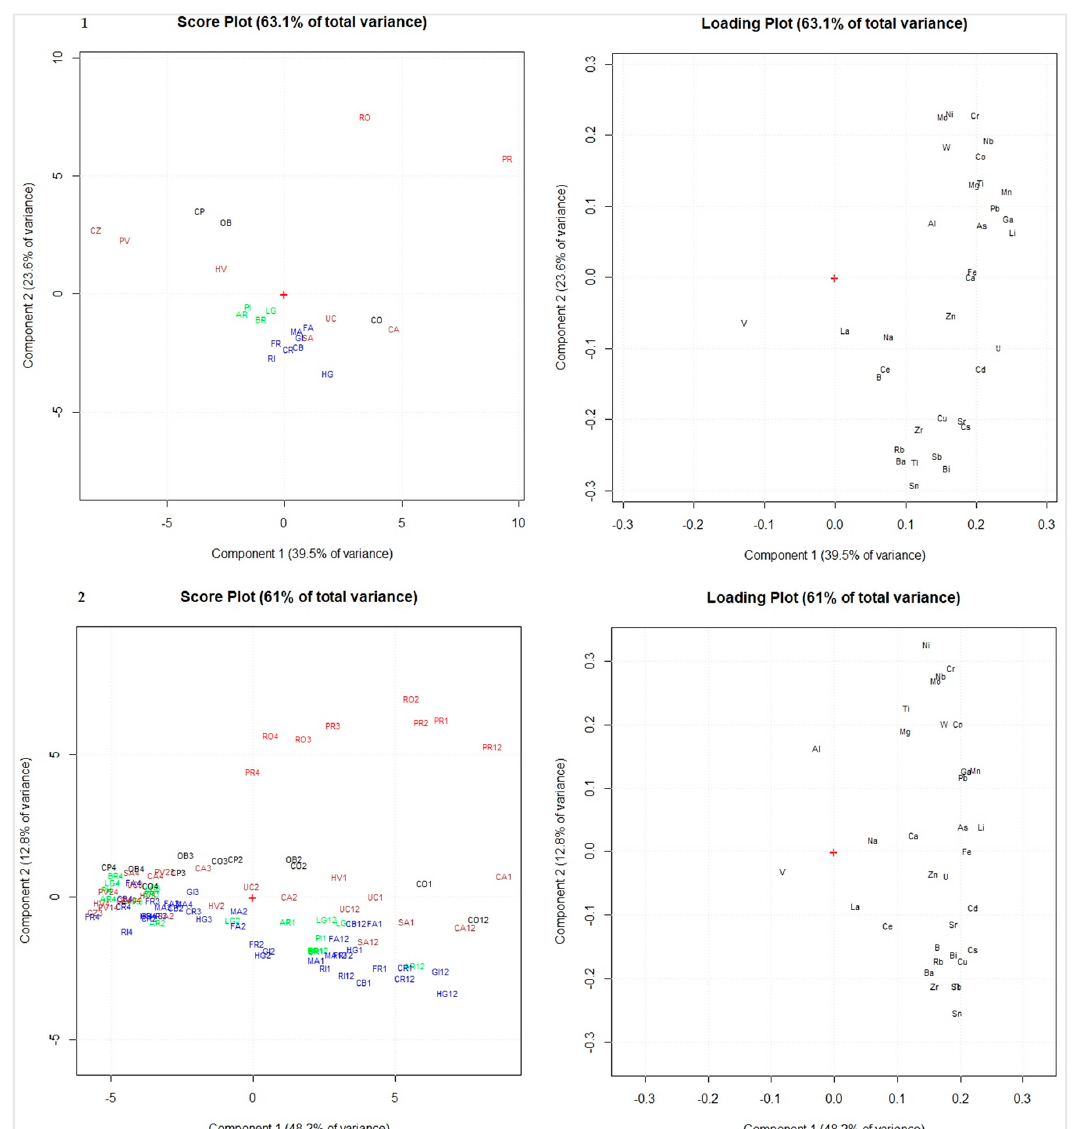
Figure 6. Panel 1—Score and loading plots of the PCA performed by using the averages of the 34 monthly total elemental concentration data recorded at each collection site. Panel 2—Score and loading plot of the PCA performed by using the 34 total elemental concentration data recorded each month at each collection site.